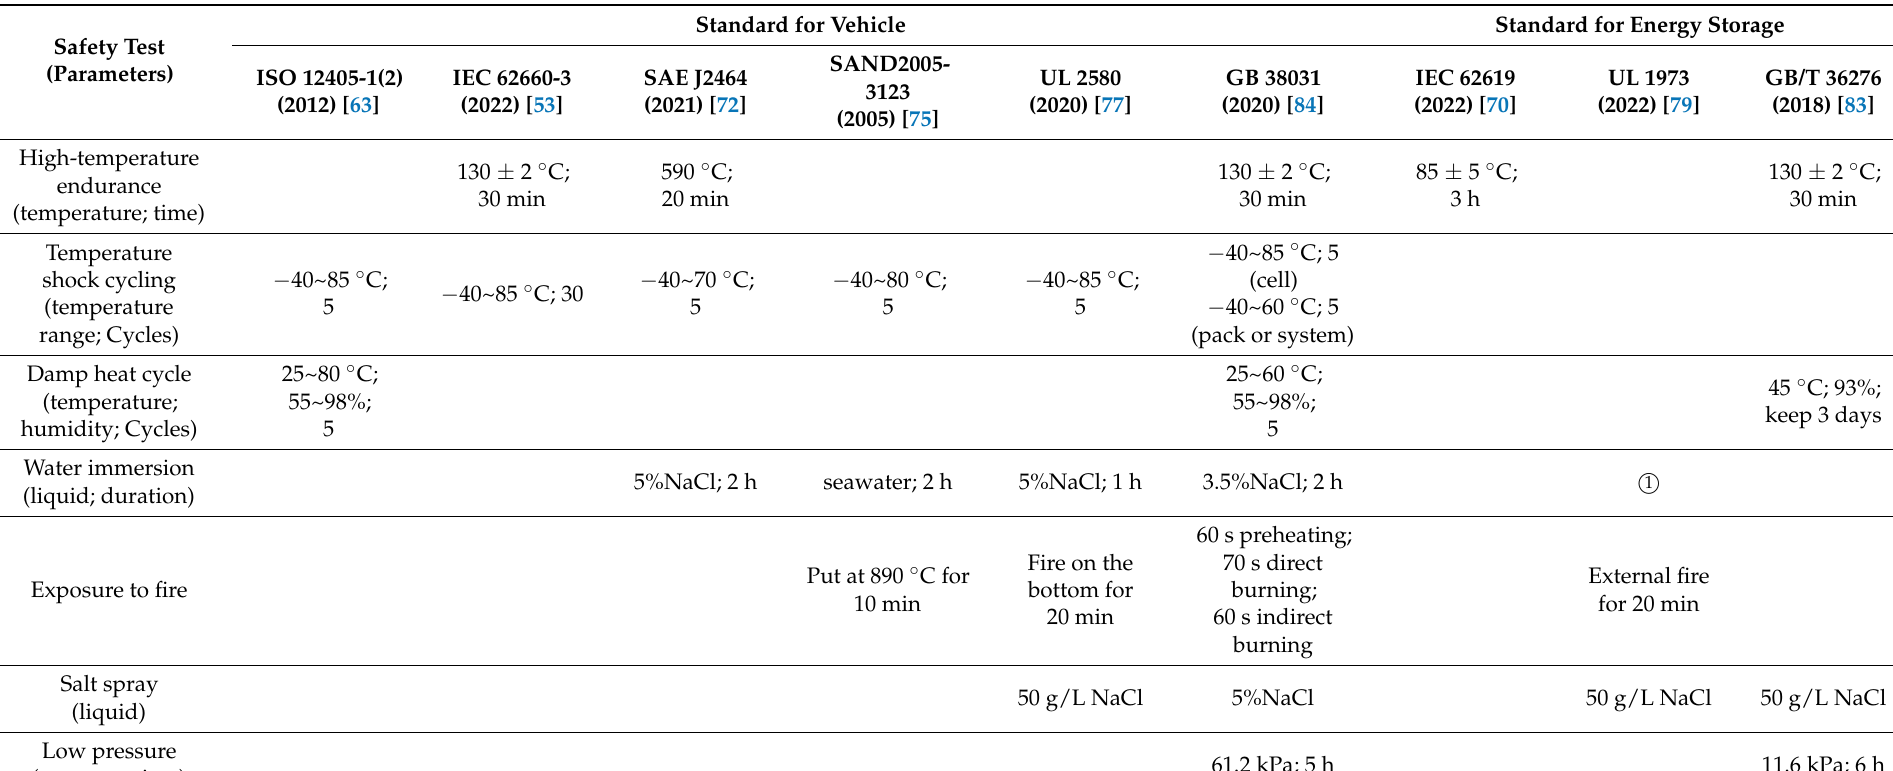
Table 6. Environmental test standards for